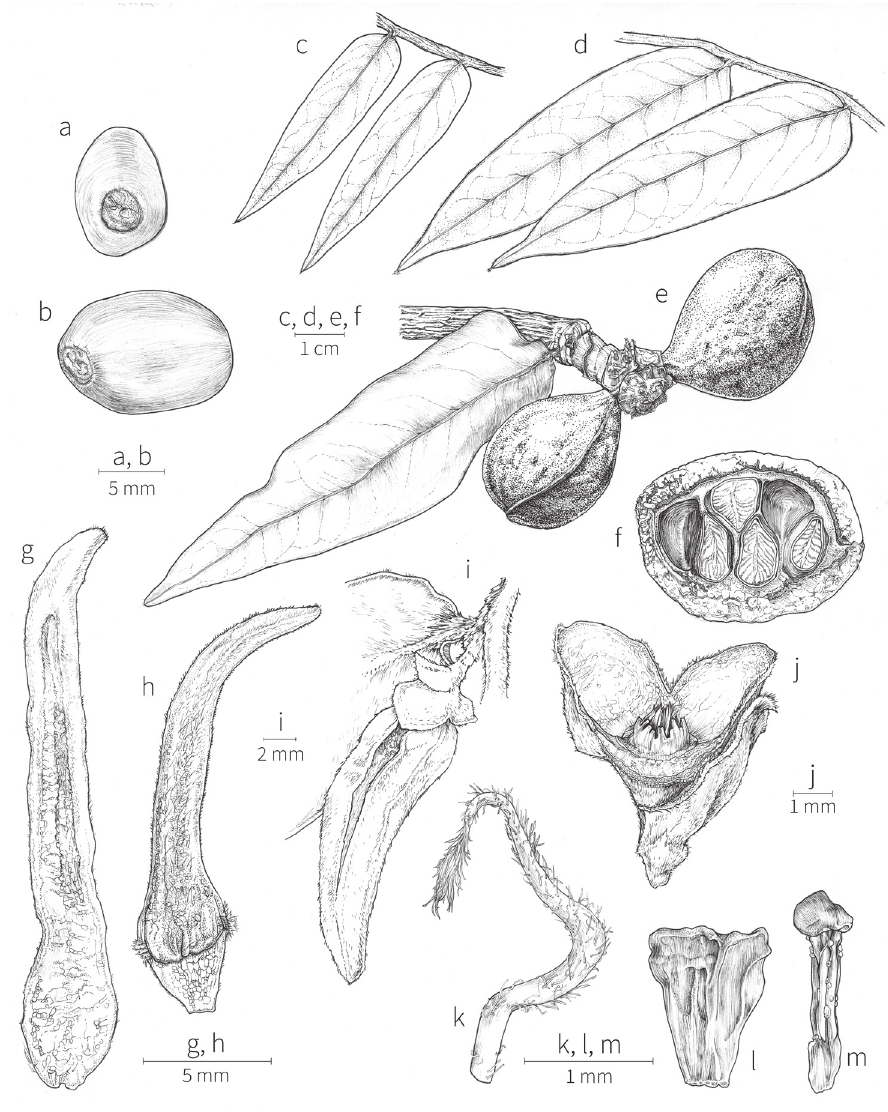
Figure 44. Xylopia letestui . A Seed, view of micropylar end B Seed, side view C, D Habit E Habit includ- ing fruit F Fruit, transmedian section showing seed arrangement G Outer petal, adaxial view H Inner petal, adaxial view I Flower bud J Bract, sepals, and staminal cone K Stigma, side view L Staminode, abaxial view M Fertile stamen, abaxial view. A, B, E, F from Breteler et al. 8867 (WAG) C from Hallé 4274 (WAG) D from Leeuwenberg 3073 (WAG) G–I from van der Burgt 1129 (MO) J–M from Le Testu 5975 (BM). 3.1–3.2 mm wide, ovate to elliptic, apex obtuse to acute, appressed-pubescent abaxi- ally. Petals cream-colored adaxially, becoming red toward the base in vivo ; outer petals with position at anthesis not determinable, 13–22 mm long, 3.0–3.7 mm wide at